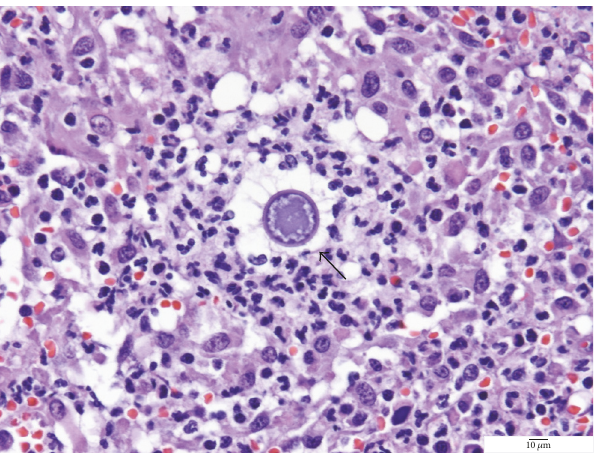
Figure 1: Immature spherule at the late segmentation phase prior to development of endospores of Coccidioides immitis (arrow) isolated from the left flank mass. The round structures are approximately 30–40um in diameter with 2um thick pale basophilic cell walls and heterogeneous amorphous pale amphophilic central material. Periodic acid Schiff (PAS)